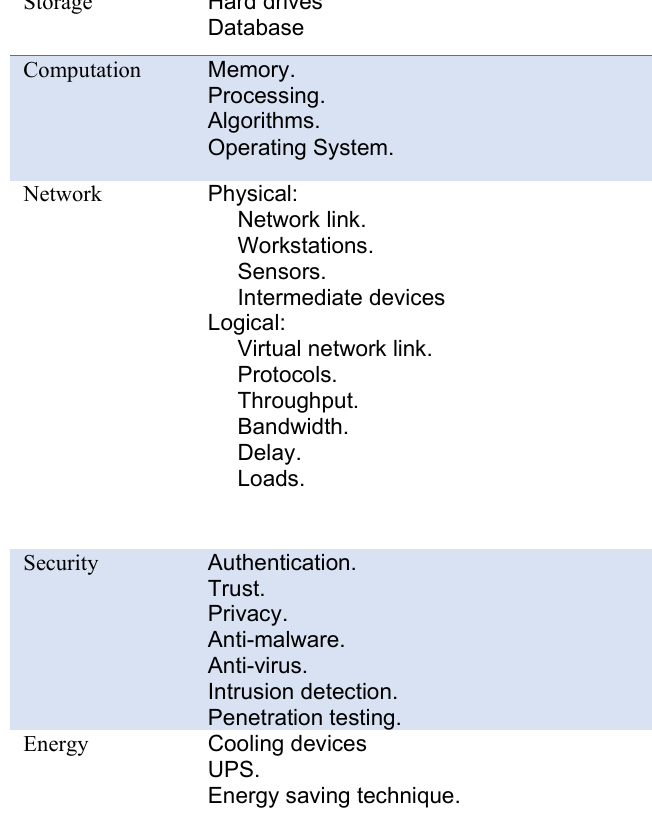
Table 1. Type of